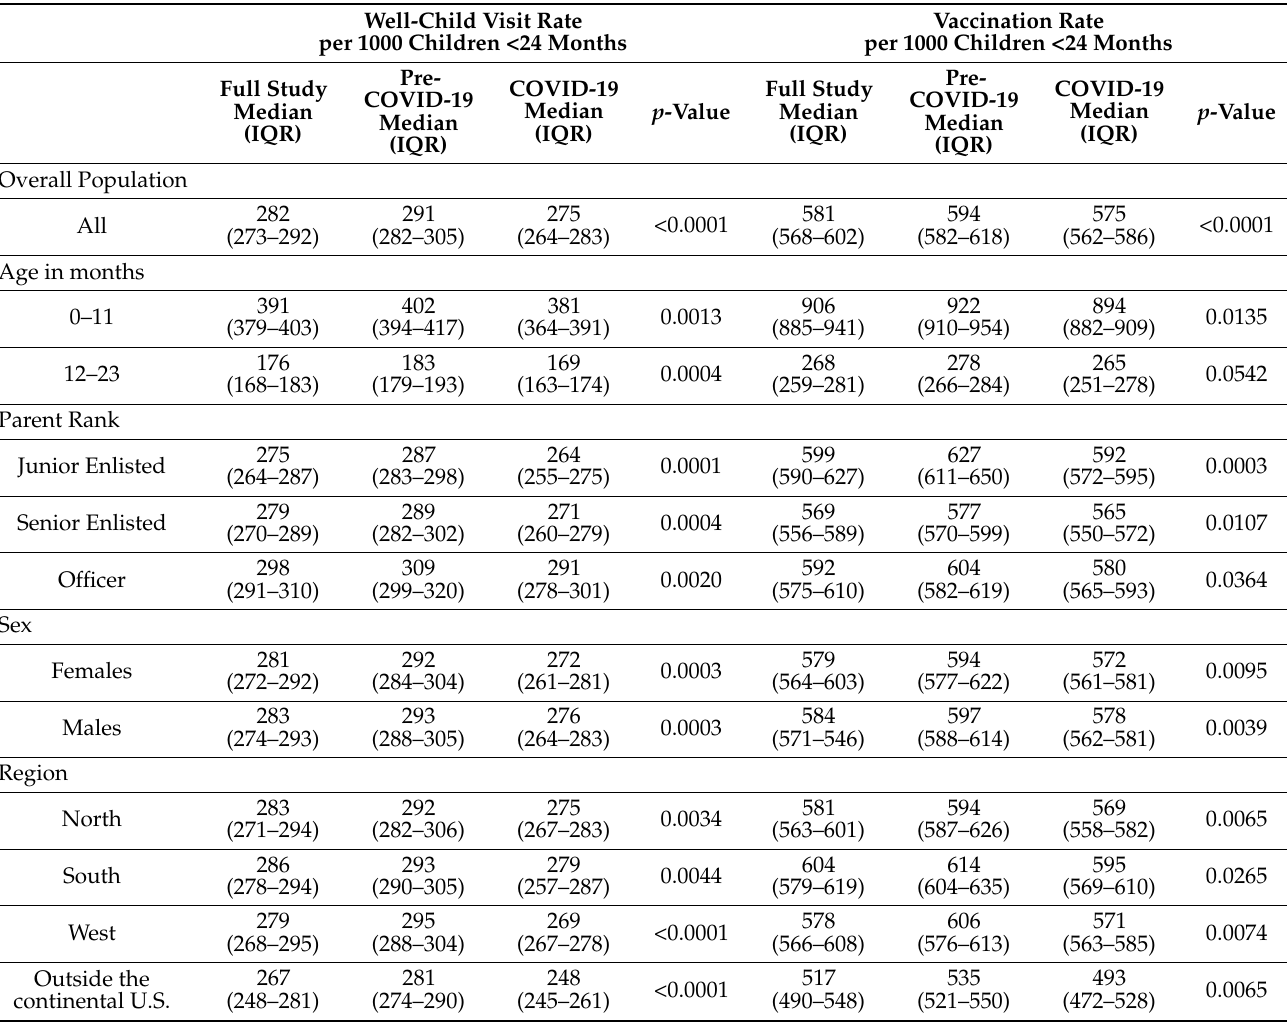
Table 2. Pre-COVID-19 versus COVID-19 Period: Median Monthly Well-Child Visit and Vaccina-